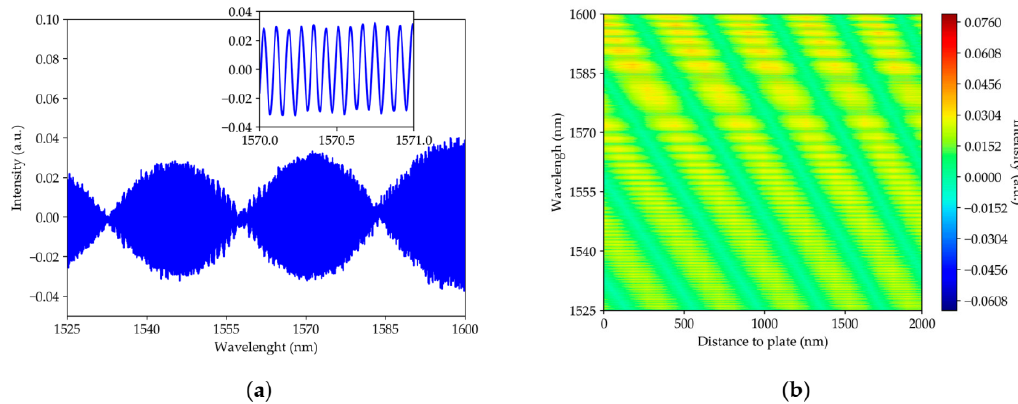
Figure 6. The two interferometers with a length of 15.4 ± 0.5 mm: ( a ) spectrum at the beginning of measurements and ( b ) intensity as a function of the distance between the optical fiber and the reflecting surface and as a function of